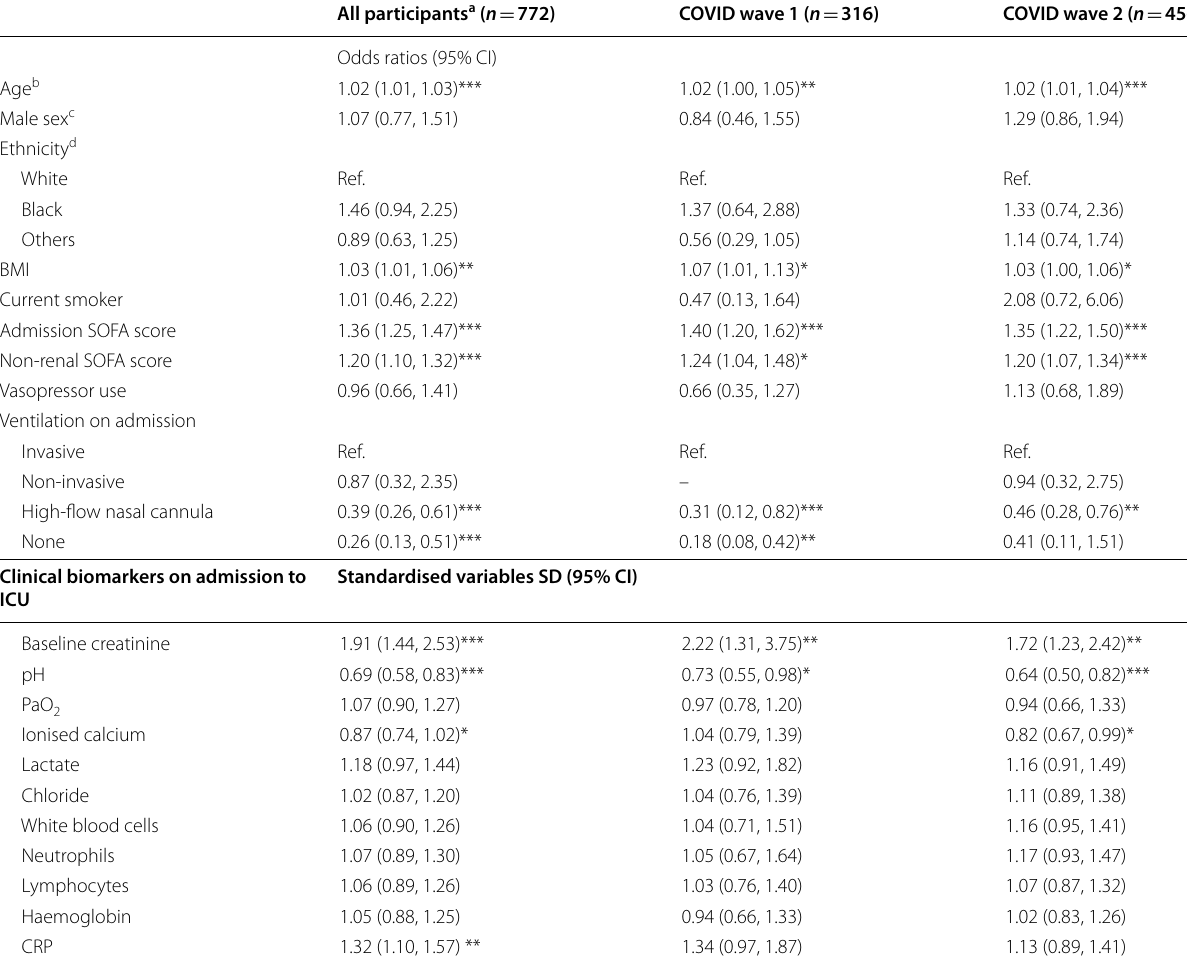
Table 3 Adjusted associations between demographic characteristics and diagnosis of acute kidney injury for all patients and stratified by